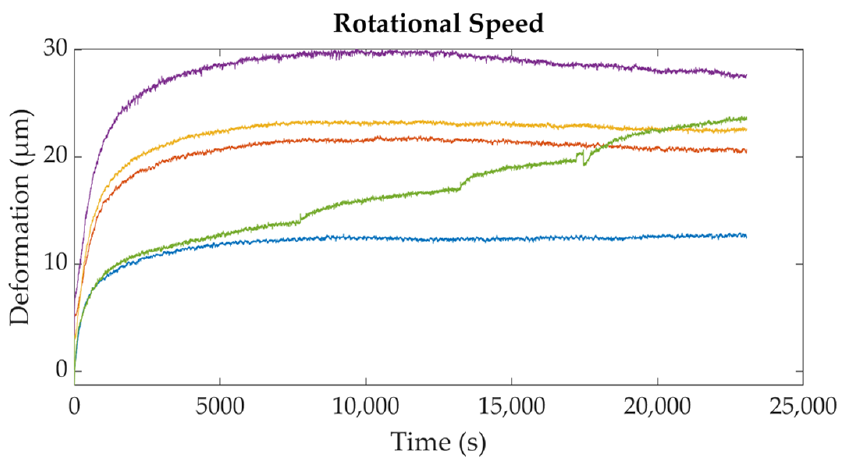
Figure 6. The demonstration of the thermal error measurement results under constant speed and variable speed.